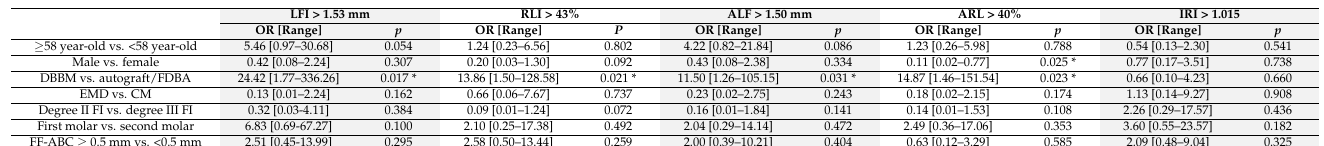
Table 3. Logistic regression for the effects of the demographic characteristics, treatment strategies, and furcation–ABC relationship in achieving a better outcome of FDR in the pure furcation defect